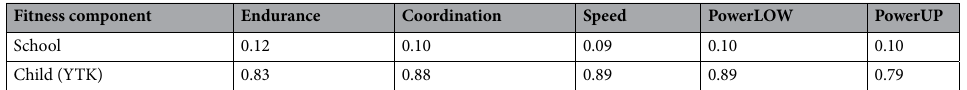
Table 5. Variance components for younger-than-keyage (YTK) children. Endurance = cardiorespiratory endurance (i.e., 6 min run test), Coordination = star run test, Speed = 20-m linear sprint test, PowerLOW = lower limbs muscle power (i.e., standing long jump test), PowerUP = upper limbs muscle power (i.e., ball push test), YTK = younger-than-keyage (YTK) children. VC for Residual = 0.62.